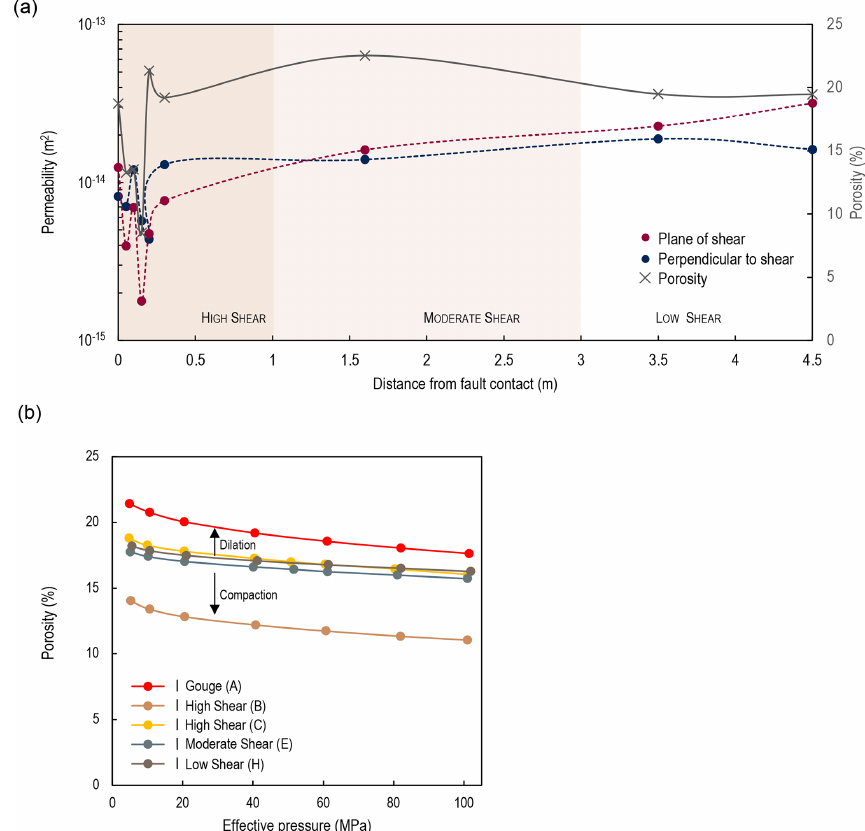
Figure 5. (a) Porosity and permeability (parallel and perpendicular to shear plane) profile across the shear zone (at P eff (cid:39) 5MPa), showing the compactant (ductile) nature of the high shear zone overprinted by localised, dilational (brittle) fractures. Measurements on the gouge sample are plotted at a distance of 0m. (b) Porosity reduction as a function of effective pressure, derived from the volume of water expelled during loading in effective pressure of samples cored parallel to shear. Note that the initial porosity value (at P eff (cid:39) 5MPa) is that of the sample initial porosity (before loading); the exact quantity of water expelled between 0.1 and 5MPa cannot be accurately determined due to the method used, and hence we simply show the porosity reduction from this point